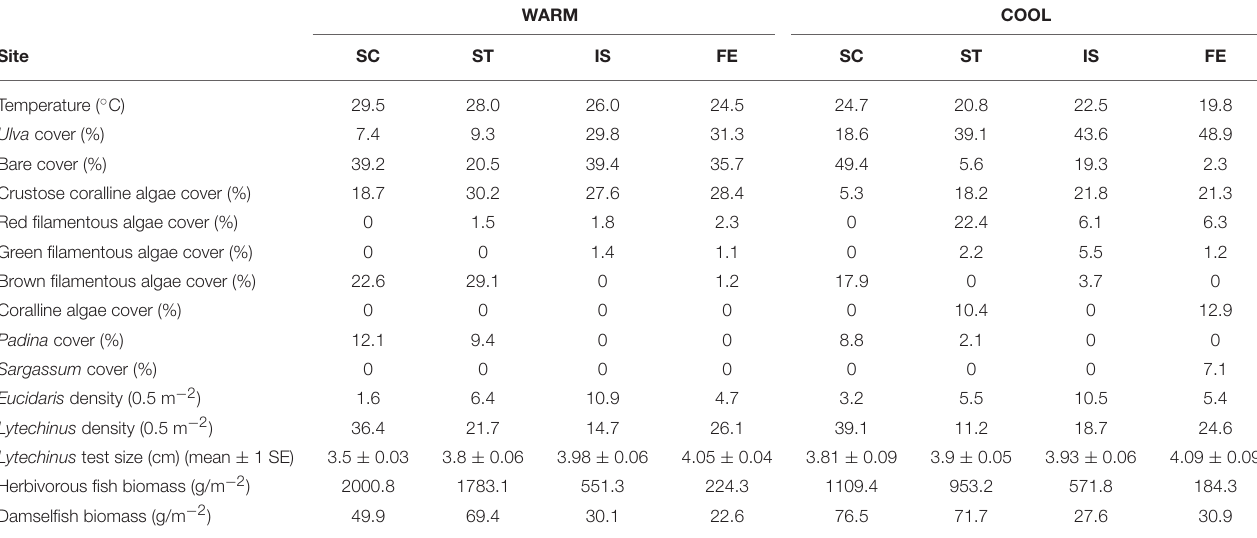
TABLE 1 | Biological and physical characteristics of the four sites used in the grazing assays. WARM COOL